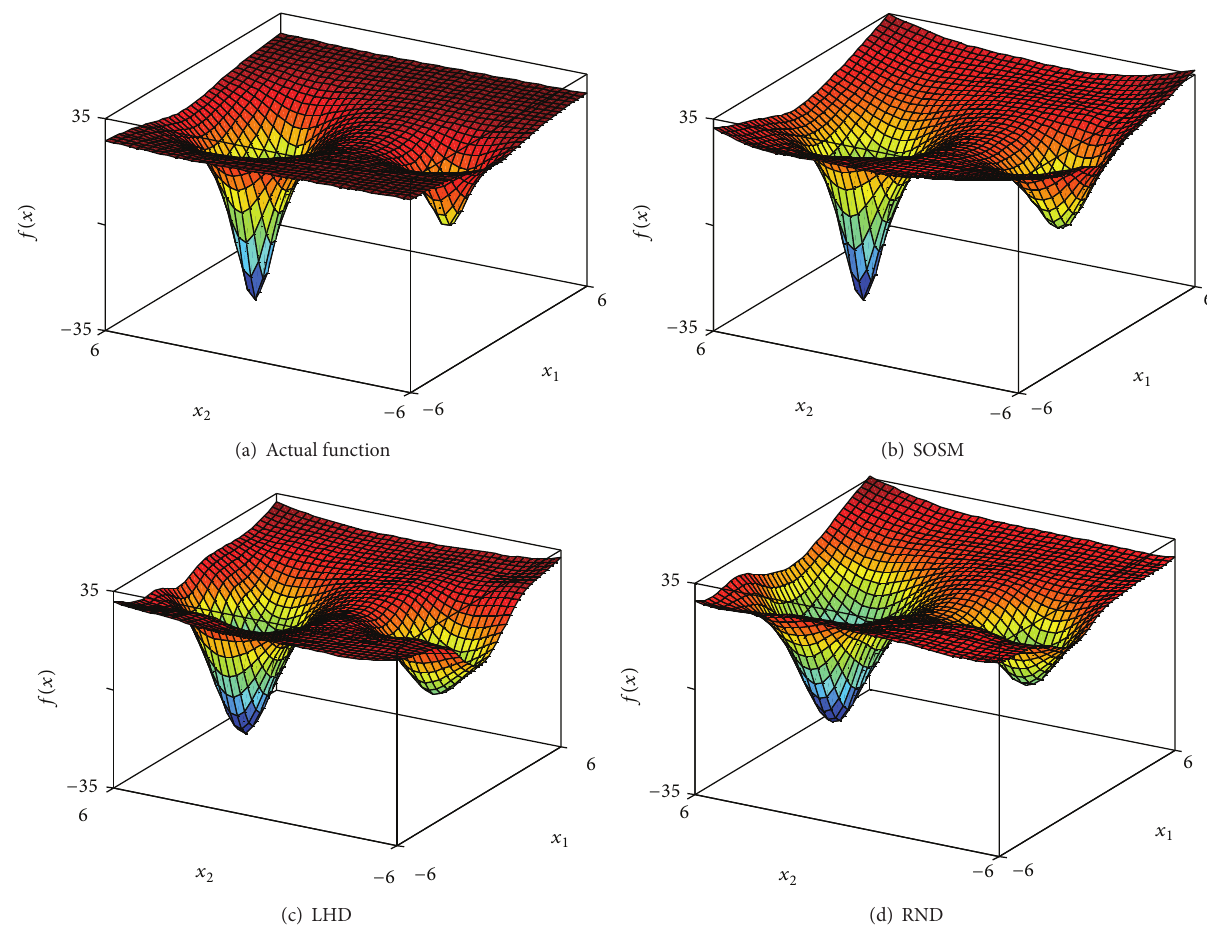
Figure 15: Function 5: actual and metamodel surface.